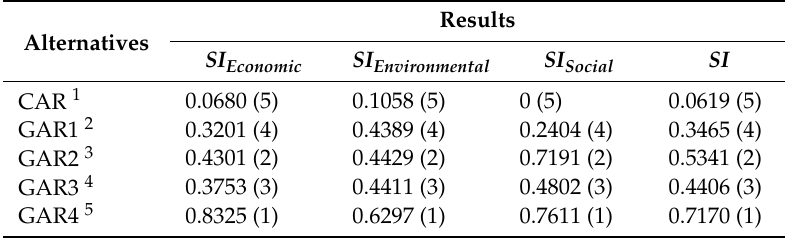
Table 11. MIVES (Spanish acronym of Integrated Value Model for Sustainability Assessment) results for the alternatives under assessment.